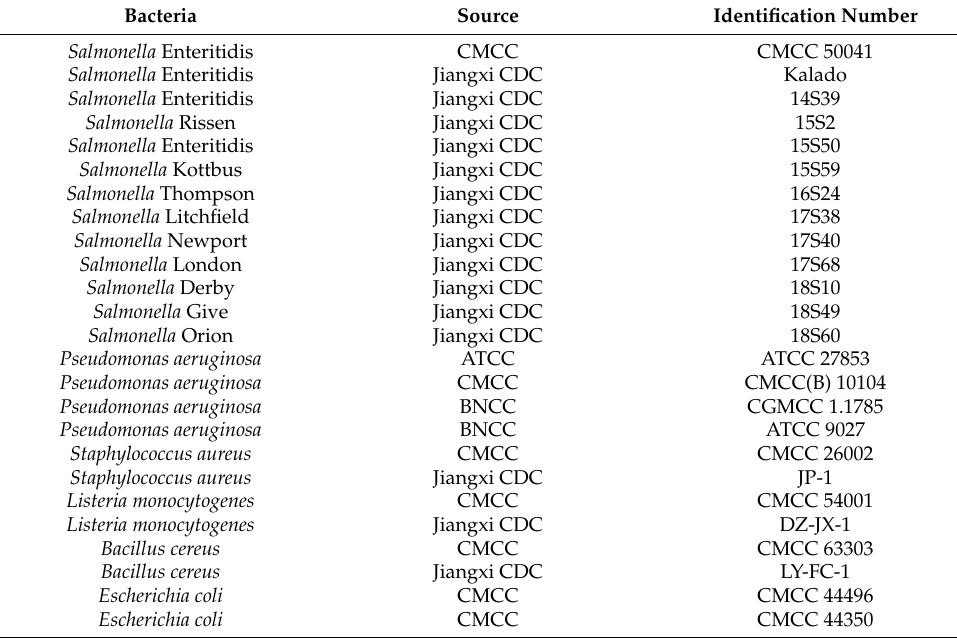
Table 1. Sources and identification numbers of